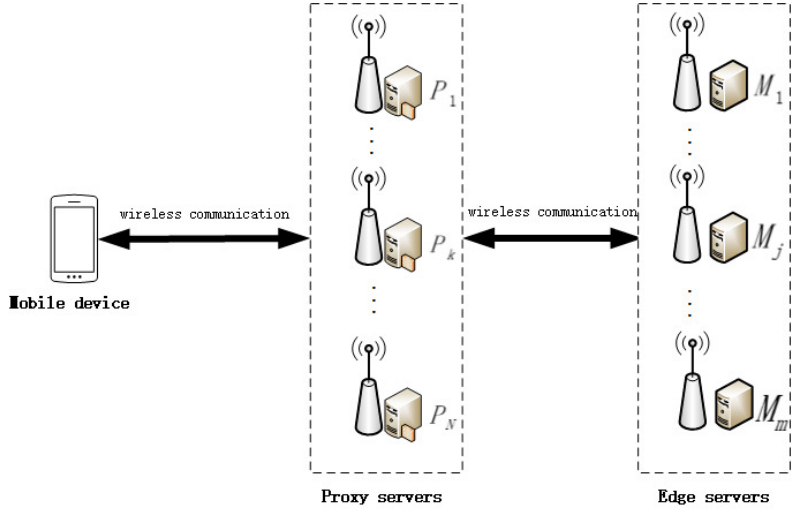
Figure 1. An example of a MEC system with privacy